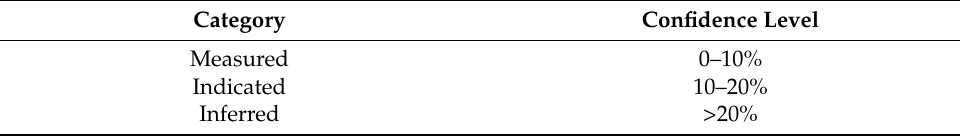
Figure 17. Map of probability for confidence intervals of 85% with a black contour line for a drillhole spacing-based approach (200 m) and a purple contour line for an uncertainty-based approach. Table 1. Resource classification based on the probability for confidence